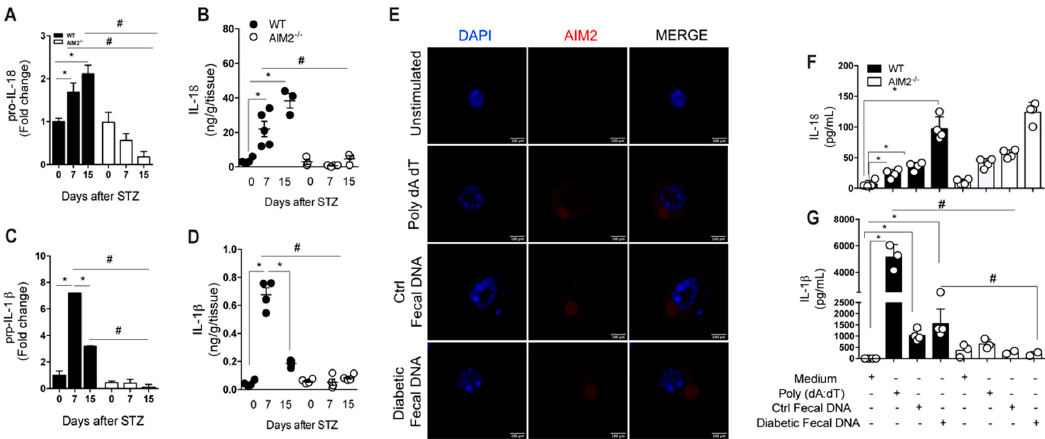
Figure 7. Deficiency of AIM2 impairs IL-18/IL-1 β production in the gut mucosa during STZ-induced T1D. ( A , B ) The gene and protein expression of IL-18 in the ileum of the WT and AIM2 − / − mice at 0, 7 and 15 days after the STZ induction. ( C , D ) The gene and protein expression of IL-1 β in the ileum of the WT and AIM2 − / − mice at 0, 7 and 15 days after the STZ induction. ( E ) Immunofluorescence of AIM2 in WT bone marrow-derived macrophages (BMDM), after 18 h of stimulation with the medium (unstimulated), Poly dA dT (AIM2 agonist), control fecal DNA, and diabetic fecal DNA. ( F , G ) The protein expression, assessed by ELISA, of the IL-18 and IL-1ß of the WT and AIM2 − / − BMDM, after 18 h of stimulation with the medium (unstimulated), Poly dA dT (AIM2 agonist), control fecal DNA, and diabetic fecal DNA. The values are expressed as the mean ± SD. The results are considered statistically significant when p < 0.05 (*; #, ∞ ). N = 3–6 animals per group. Significant di ff erences between the groups were determined by one-way ANOVA, followed by Tukey’s multiple-comparison